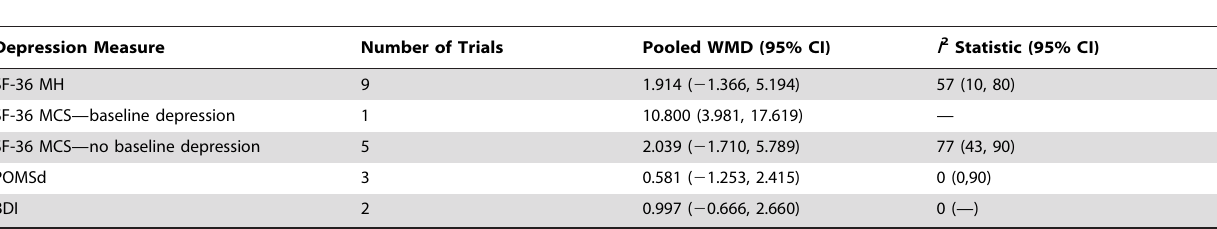
Table 5. Pooled weighted mean differences in depression score for CPAP